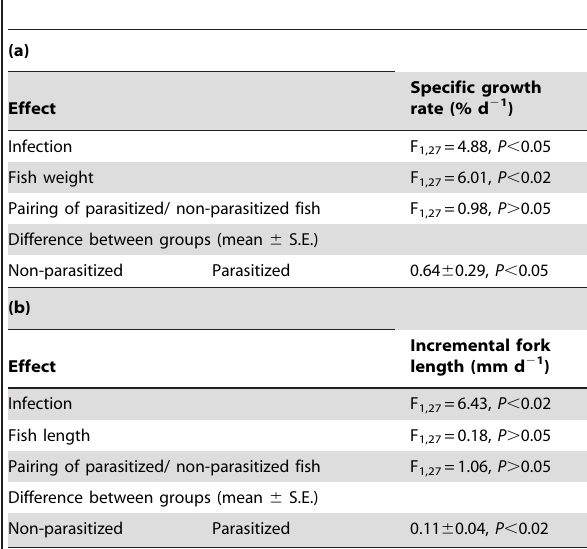
Table 3. Infection effects of Bothriocephalus acheilognathi on the growth of Cyprinus carpio .